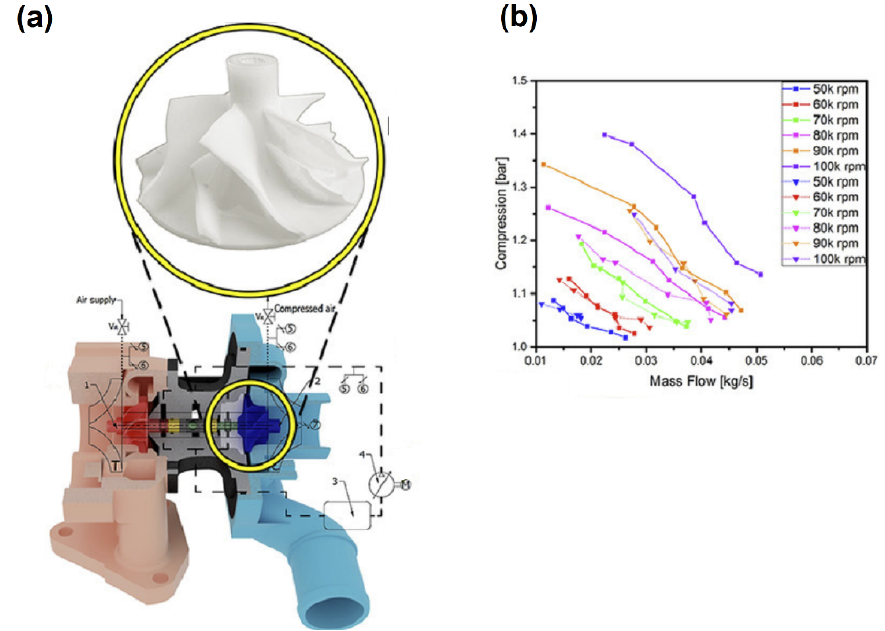
Figure 2. ( a ) Cross section of turbocharger with compressor wheel fabricated by MJP and ( b ) experimental results of polymeric (dotted lines) and aluminum (solid lines) compressor wheels (reprinted with permission from [9]).